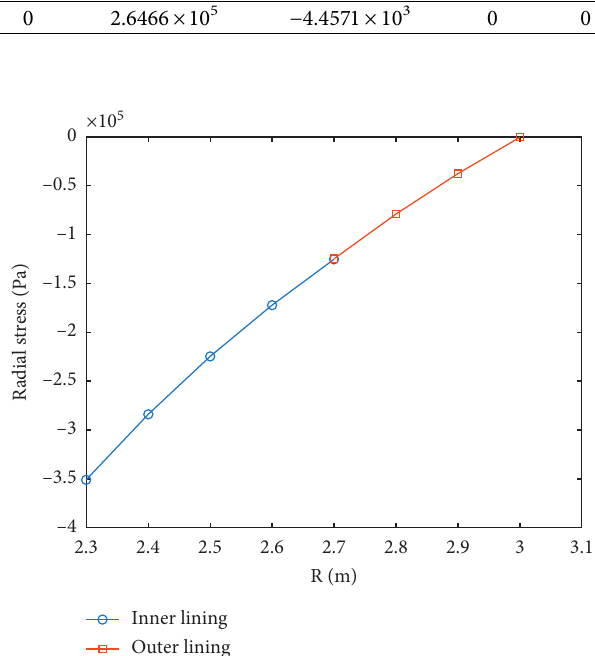
Figure 5: Distribution of radial stress under internal pressure.